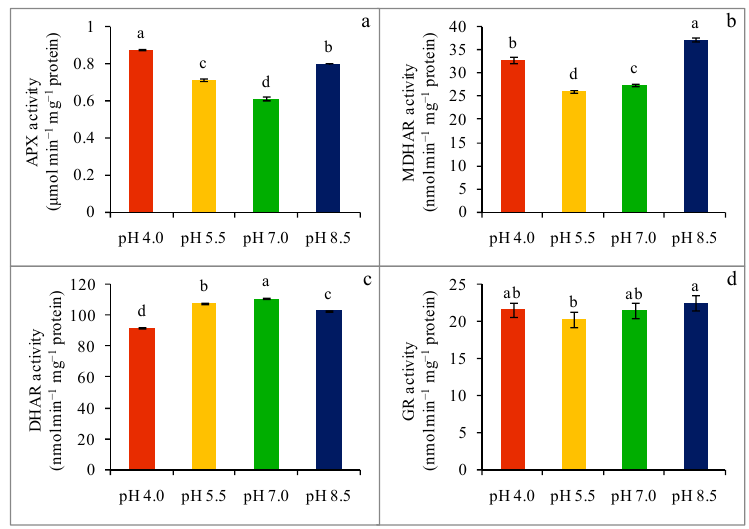
Figure 5. Activities of APX ( a ), MDHAR ( b ), DHAR ( c ), and GR ( d ) of wheat leaves under different levels of pH. Mean (±SD) was computed from three replications of each treatment. Bars with dissimilar letters are significantly different at p ≤ 0.05 from Fisher’s LSD test.